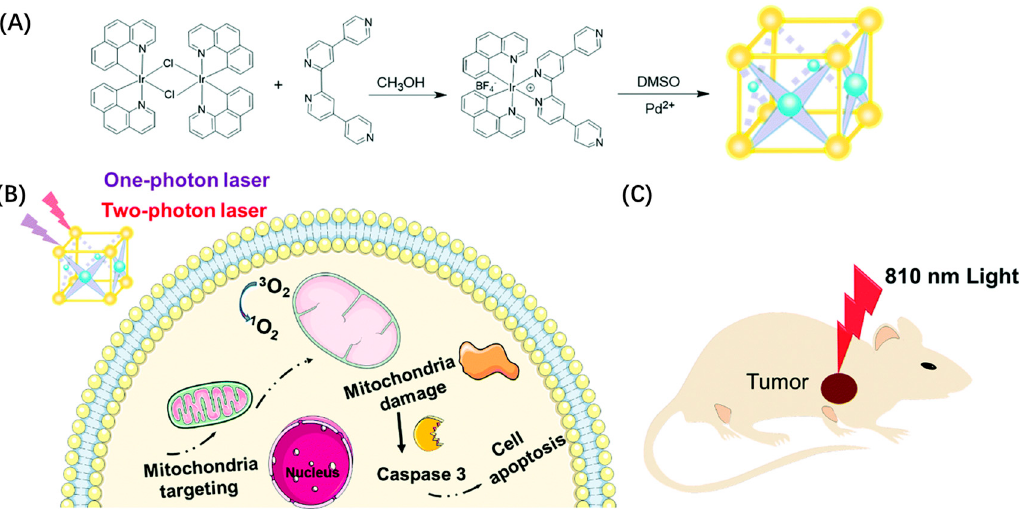
Figure 9. ( A ) Synthesis of MOC-53 . ( B , C ) Schematic diagram of the PDT effect of MOC-53 on a tumor-bearing mouse under 810 nm light irritation. Reprinted with permission from [84]. Copyright 2022 Royal Society of Chemistry.